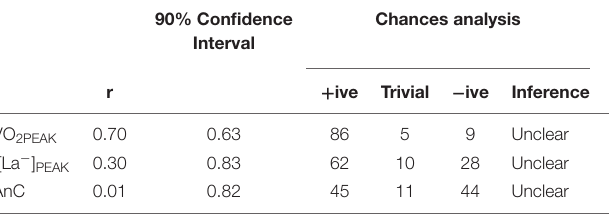
TABLE 2 | Correlations between physiological parameters determined in the laboratory condition (LaB) and simulated games (GaM).